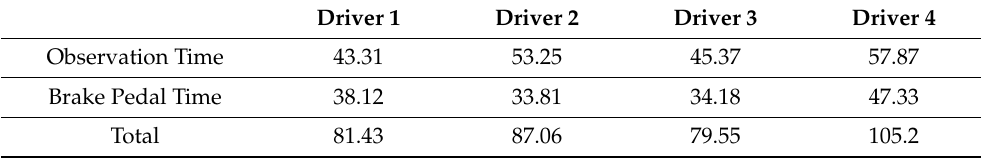
Table 7. Eye-tracking evaluation of drivers’ reaction